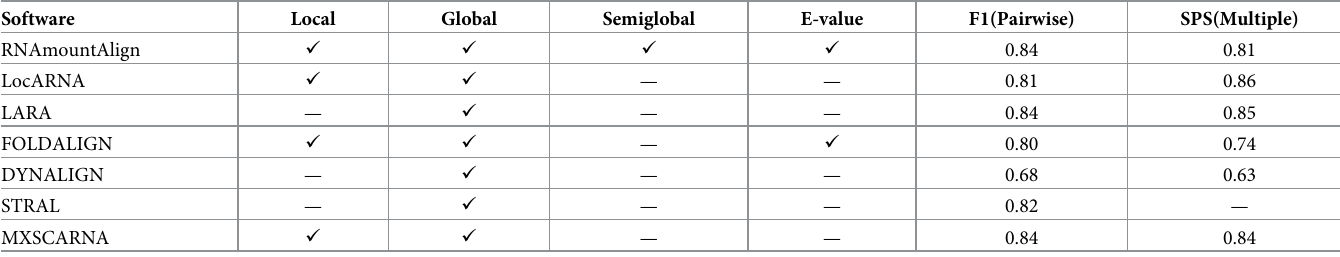
Table 2. Software